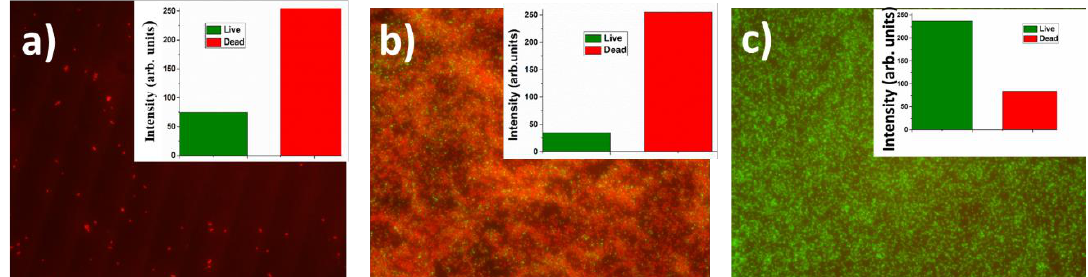
Figure 7. Optical images of assays of live (green) and dead (red) cells in Staphylococcus aureus bacterial biofilms incubated on silica glass slides pre-coated by metallic nanoparticles transferred from the PET substrate: ( a ) Ag; ( b ) Cu; ( c ) Au (the instrumental magnification–600×). Insets: RGB analysis of live and dead bacteria. Image size-30 × 25 μm .